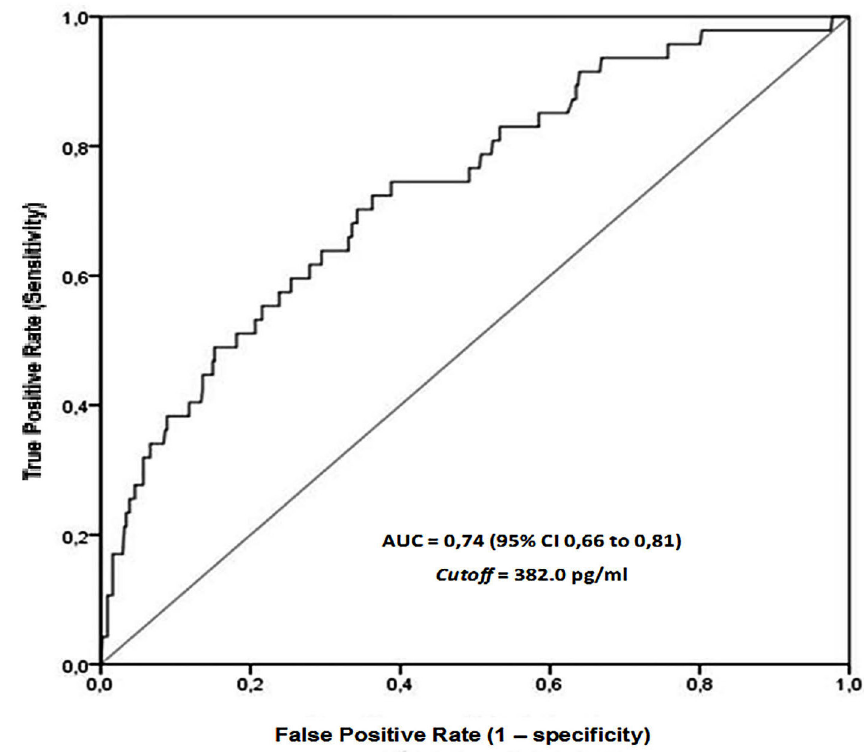
Fig. 1 - ROC (Receiver Operating Characteristic) curve relating preoperative serum brain natriuretic peptide (BNP) and mortality from